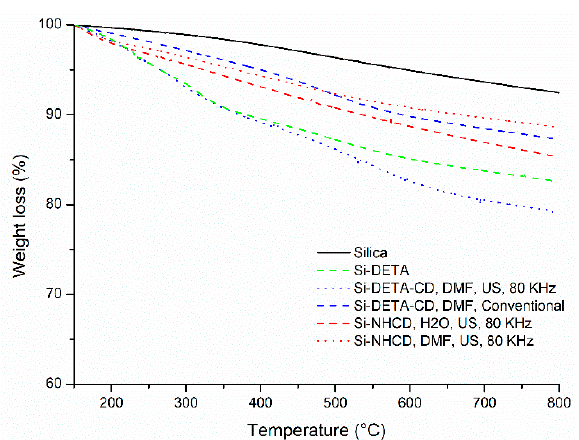
Figure 4. TGA profile of starting silica, Si-DETA (green line), Si-NHCD (red lines), and Si-DETA-CD (blue lines) prepared conventionally or under US irradiation. Solid line, starting silica; red, dotted line, Si-NHCD US irradiation 80 kHz in DMF for 2 h, Table 1, Entry 20; blue, dashed line, Si-DETA-CD conventional heating in DMF at 70 ◦ C for 24 h, Table 1, Entry 16; red, dashed line, Si-NHCD US irradiation 80 kHz in H 2 O for 2 h, Table 1, Entry 21; green, dashed line, Si-DETA; blue, dotted line, Si-DETA-CD US irradiation 80 kHz in DMF for 4 h, Table 1, Entry 17.